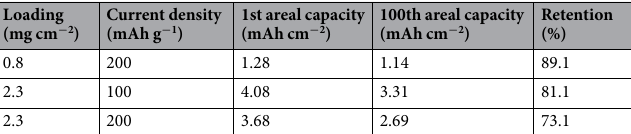
Loading (mg cm − 2 )